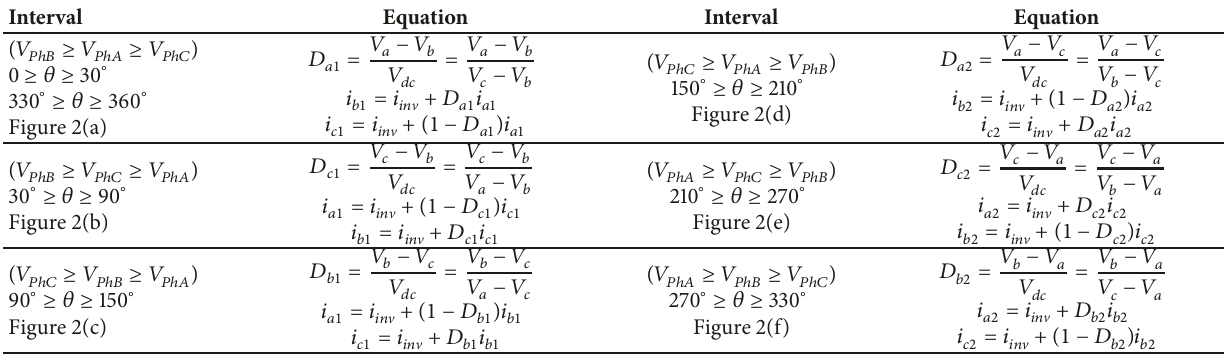
Table 1: Mathematical description of the proposed BCPWM technique during the different intervals. Inte r val